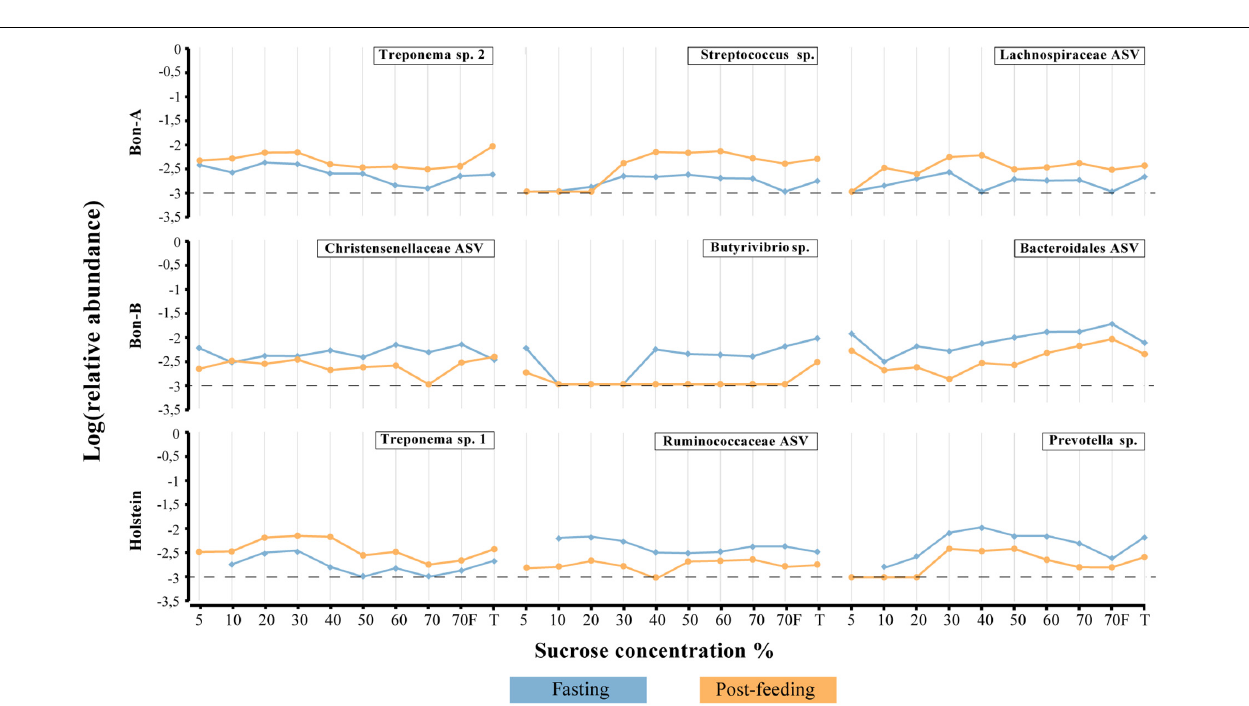
FIGURE 5 | ASVs that were significantly enriched in all the fractions of the gradient before or after feeding. (A) BON-A, (B) BON-B, and (C) Holstein. The graphics were made using the program STAMP program using Welch’s test with a p -value < 0.01. No FDR correction was made.